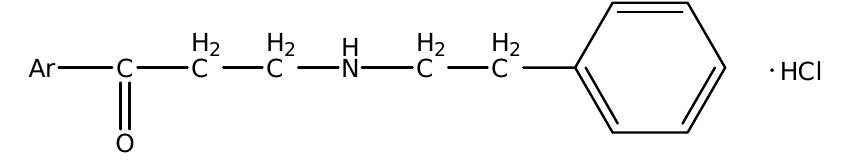
Figure 1. Chemical structures of the synthesized compounds 1 -10 .